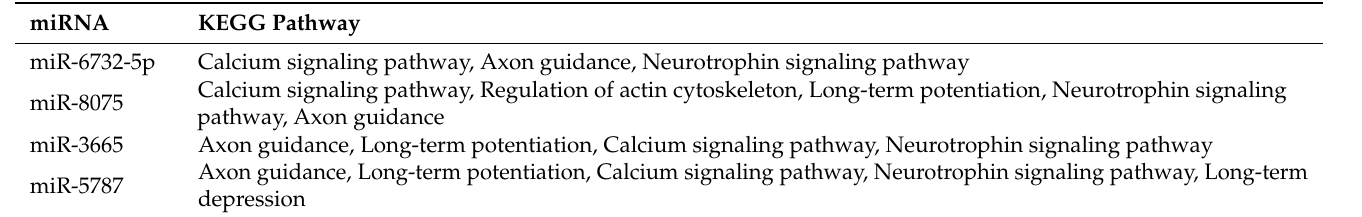
Table 1. Functional classification of miRNAs differentially expressed in GABA-treated Caco-2 cells.